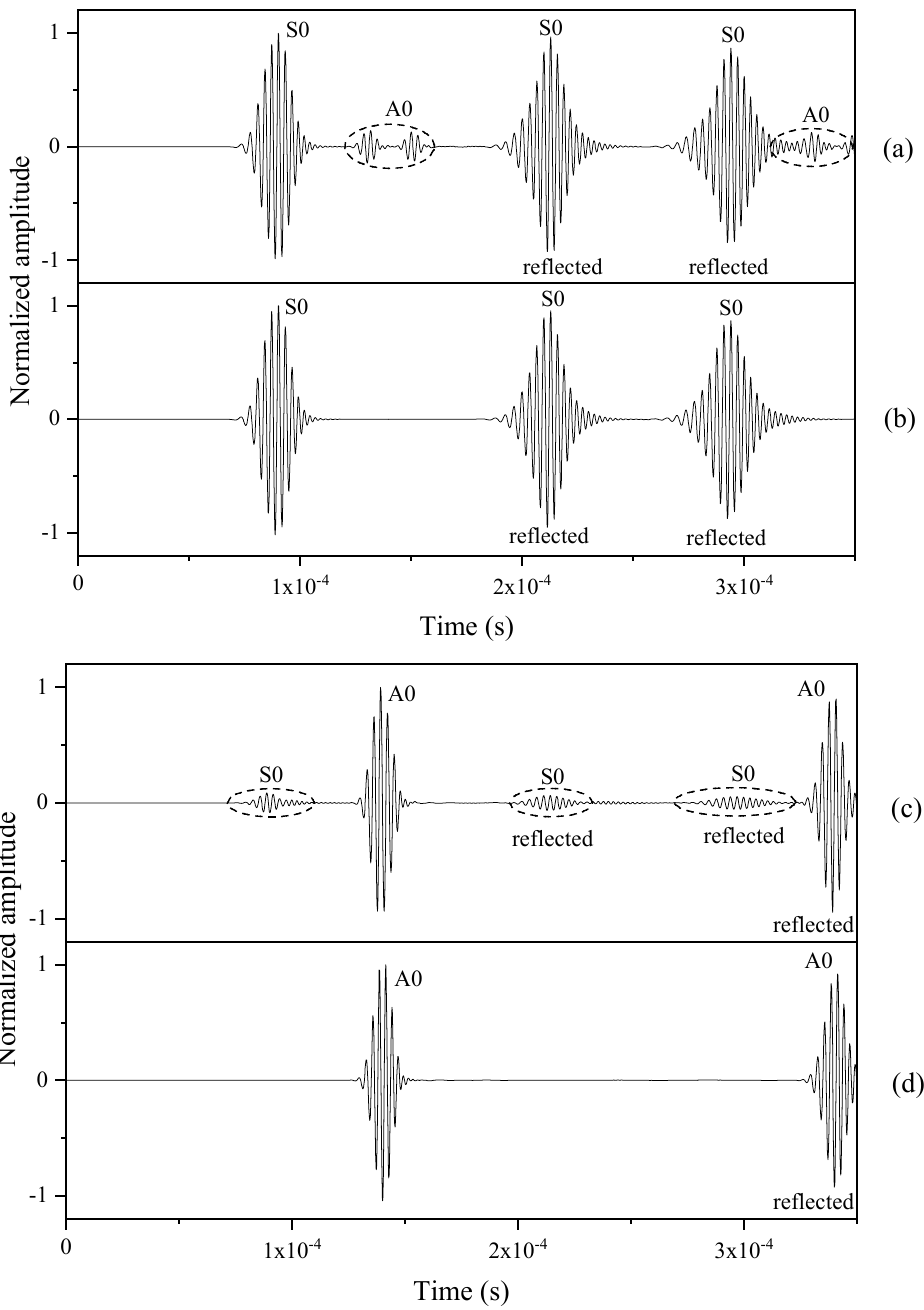
Figure 6. Results of simulation. The observed Lamb wave harmonic displacement, S0 mode, generated by ( a ) traditional EMAT and ( b ) paired NB-EMAT; A0 mode, generated by ( c ) traditional EMAT and ( d ) paired PB-EMAT.